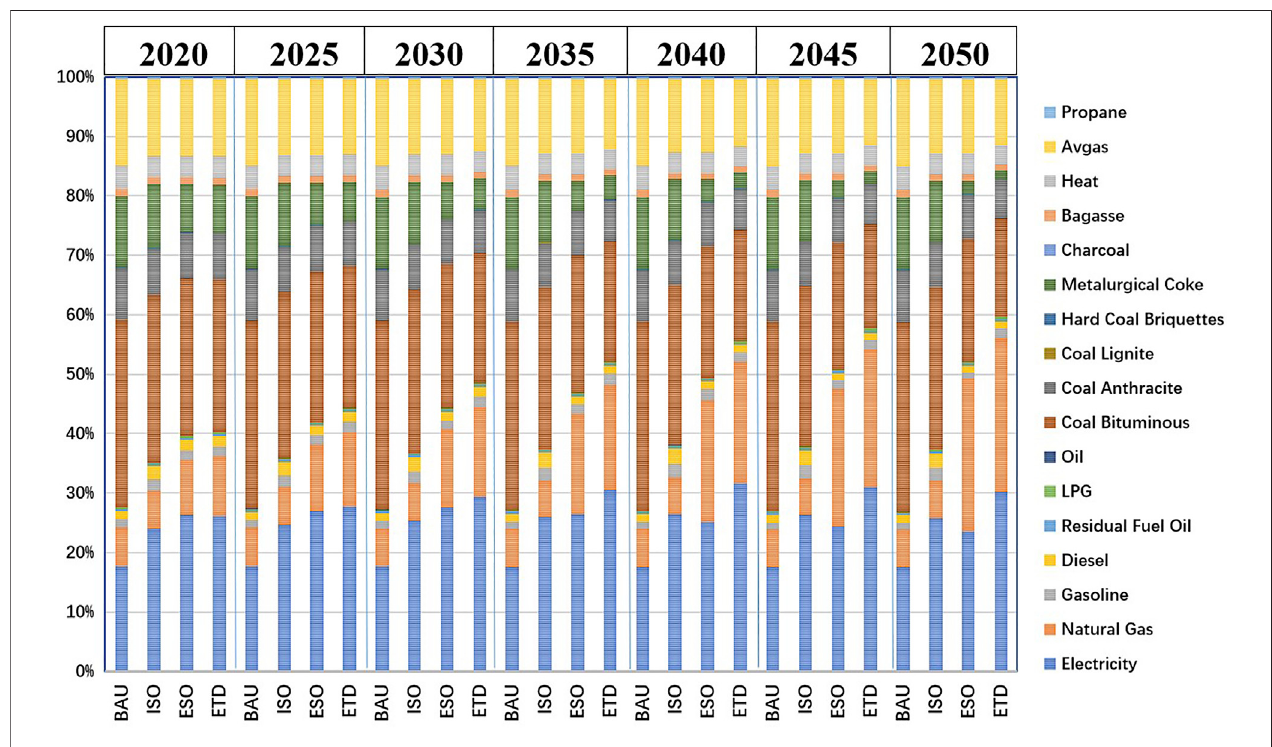
FIGURE 4 | Energy demand under the four scenarios in Tangshan.